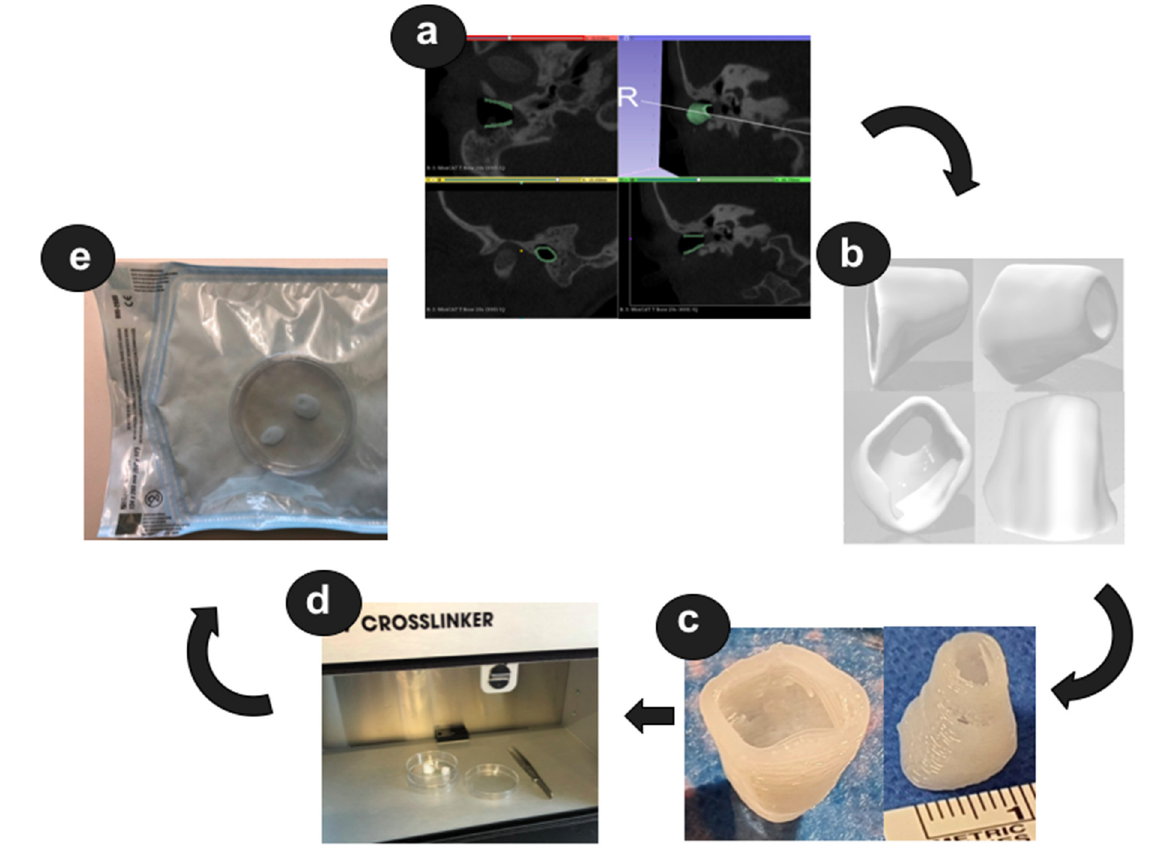
Figure 2. Development of a 3D-printed external ear canal implant (EECI). ( a ) Manual segmentation of the area to be implanted (green); ( b ) digital model of the EECI exported as STL data; ( c ) 3D-printed EECI; ( d ) irradiation of the implant using the UV crosslinker; ( e ) irradiated implant packed in the autoclaved pouch.